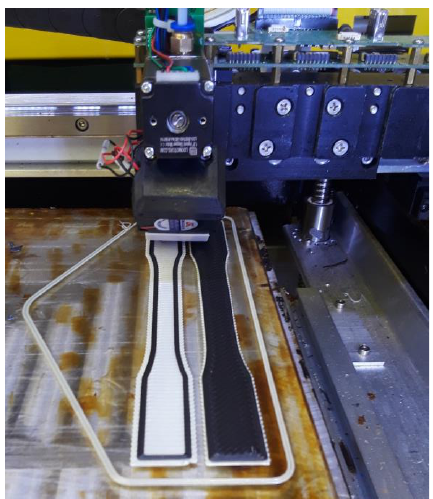
Figure 1. Hyrel Hydra with a MK1-450 head printing ULTEM 9085CF on an ULTEM 9085 raft on a 200 °C glass bed with a solution of PVA glazed on top. 200 ◦ C glass bed with a solution of PVA glazed on Samples cut from printed coupons of ULTEM 9085, ULTEM 9085CF, and ULTEM